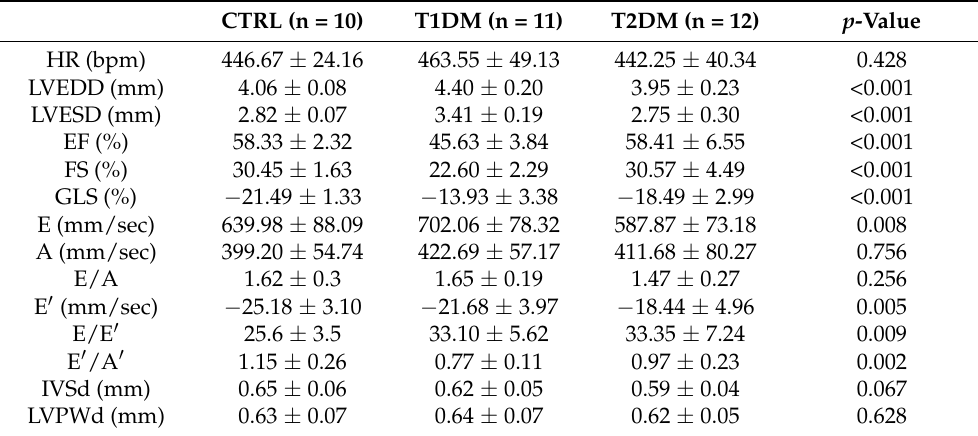
Table 1. Echocardiographic